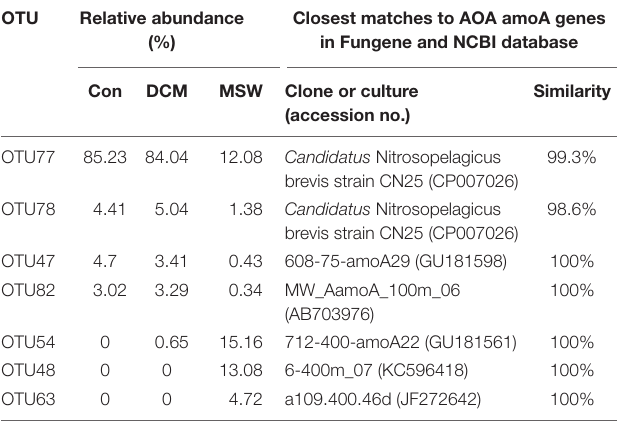
Two parallel averages were used to calculate the relative abundance values in the